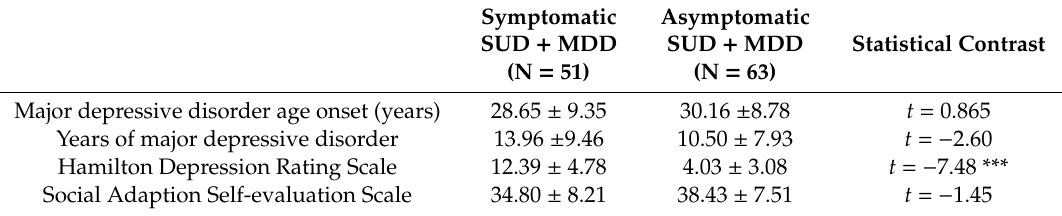
Table 2. Clinical measures (means and standard deviation) for de dual disorder group with Substance Use Disorder and Major Depressive Disorder according to the presence / absence of depressive